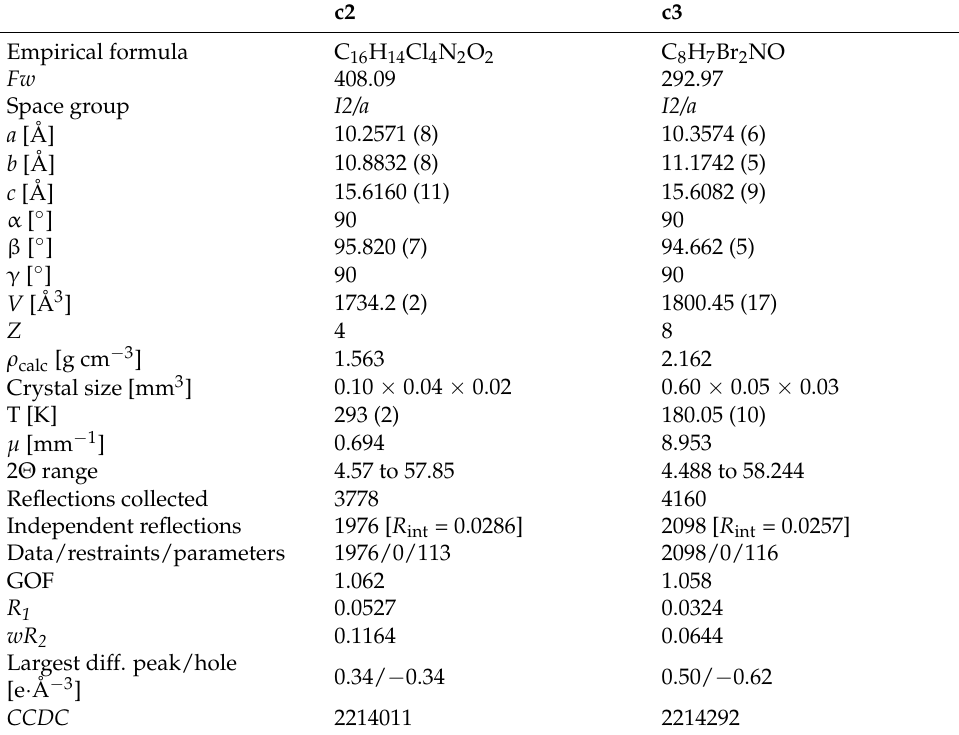
Table 3. Crystal data and details of data collection for the c compounds .